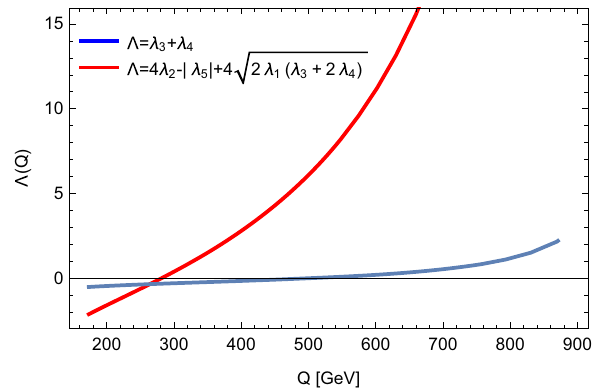
Fig. 1 Thescaledependenceoftwocombinationsofquarticcouplings. The input parameters at m t have been λ 1 = 0 . 05, λ 2 = 0 . 5, λ 3 = − 1 . 5, λ = 1, λ = 5. Negative values would point towards UFB directions, 4 5 i.e. it is shown that these directions disappear at large energy